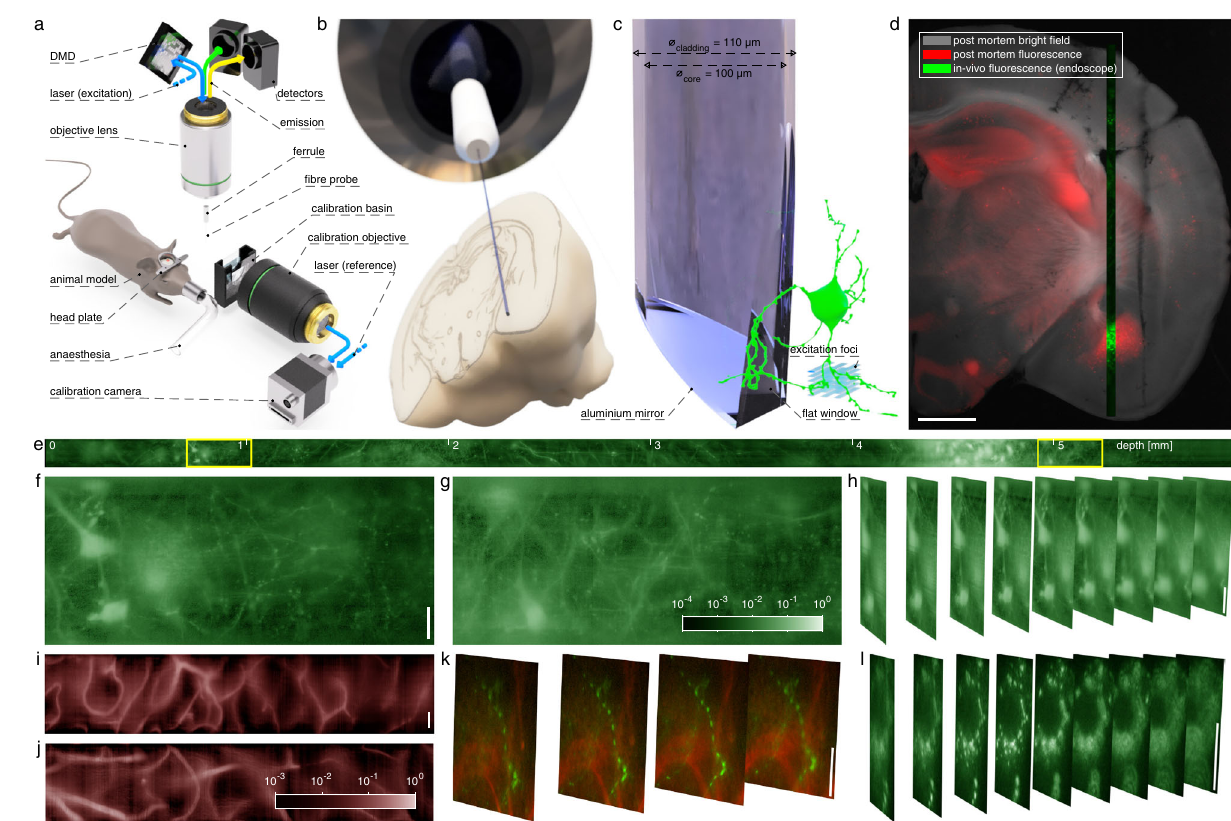
Fig. 1 | Deep-brain in vivo structure imaging using 110 μ m thick MMF endo-microscope. a Experimental geometry for TM acquisition and imaging (see "Methods"fordetails). b To-scale fi breprobeandmousebrain.Thebrainmodelhas been compiled using Allen Reference Atlas — Adult Mouse 56 , available from atlas. brain-map.org. c Detailoftheside-view fi breprobeand3-Dgridoffociscanningthe scene. d Overlayin vivo MMF endo-microscope record detailed in ( e – h ) with post- mortem bright- fi eld and confocal fl uorescence microscopy. Another parallel endoscope insertion trace is visible on the right. e Record of endoscope progres- sion (single focal plane set to the distance of 25 μ m away from the probe tip) throughout the whole-brain depth of a Thy1-GFP line M mouse (see also Supple- mentary Movie 1 for volumetric data). f , g Details of the same record from